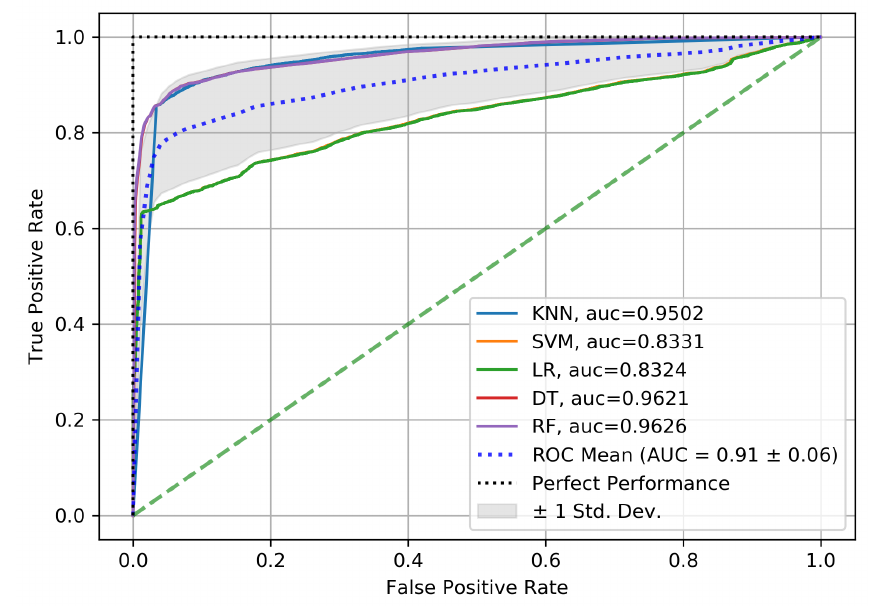
Figure 3. Receiver Operating Characteristic (ROC) for balanced subset